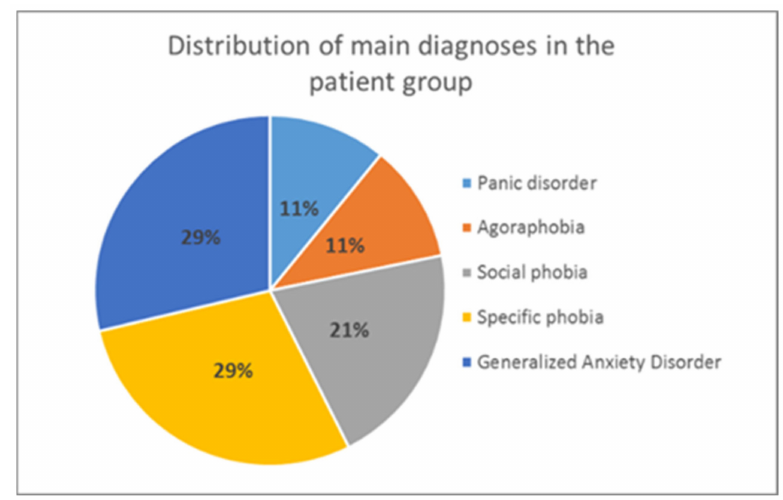
Figure 2. Distribution of anxiety disorders in the patient group. Only primary diagnoses are